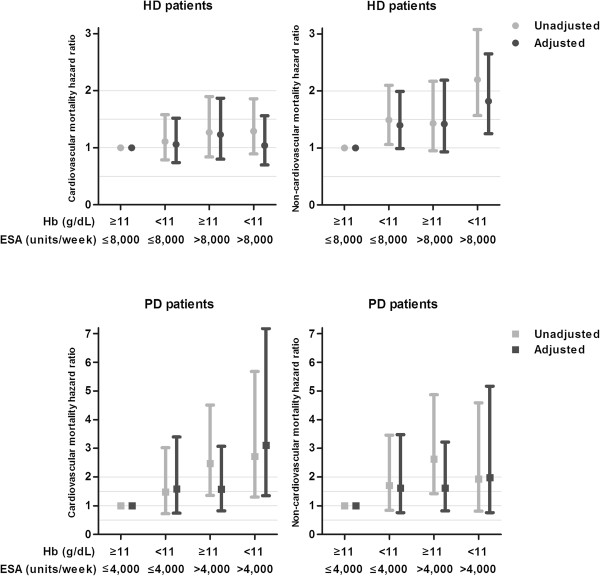
Hazard ratios for cardiovascular and non-cardiovascular mortality by ESA and Hb category. Values are shown as hazard ratios (95% Confidence intervals). Adjusted for age, sex, weight, primary kidney disease, diabetes mellitus, malignancy, cardiovascular disease, weekly Kt/V urea, rGFR, nutritional status, albumin, ferritin, PTH and CRP.